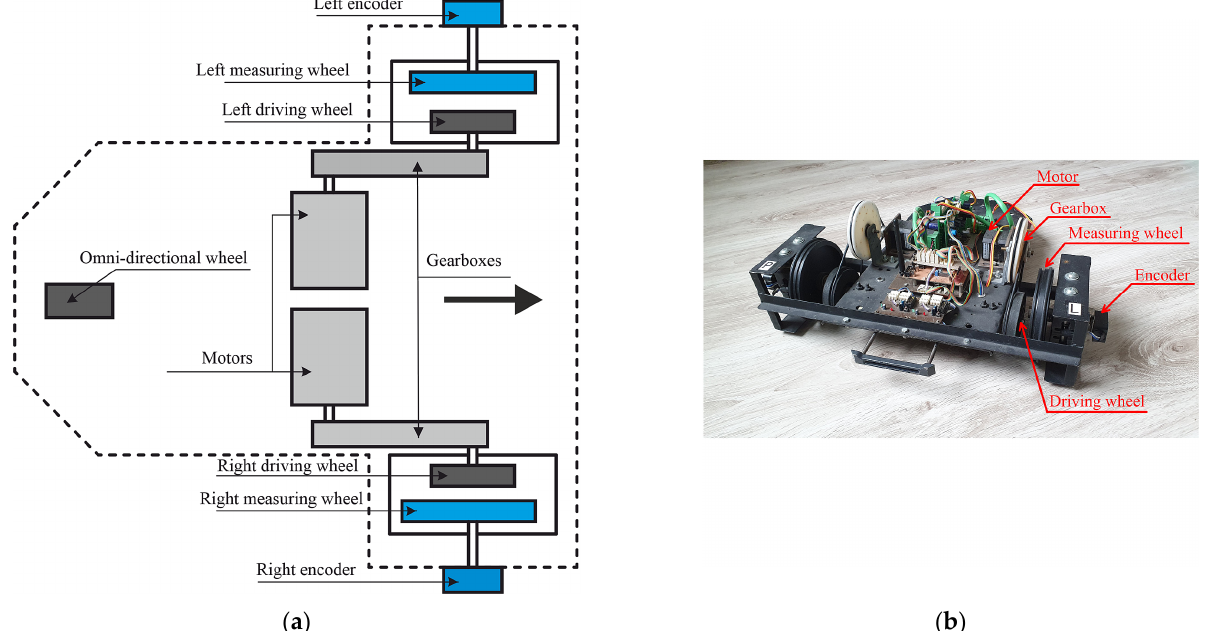
Figure 3. ( a ) EN20 mobile robot chassis scheme; ( b ) picture of the EN20 robot platform.